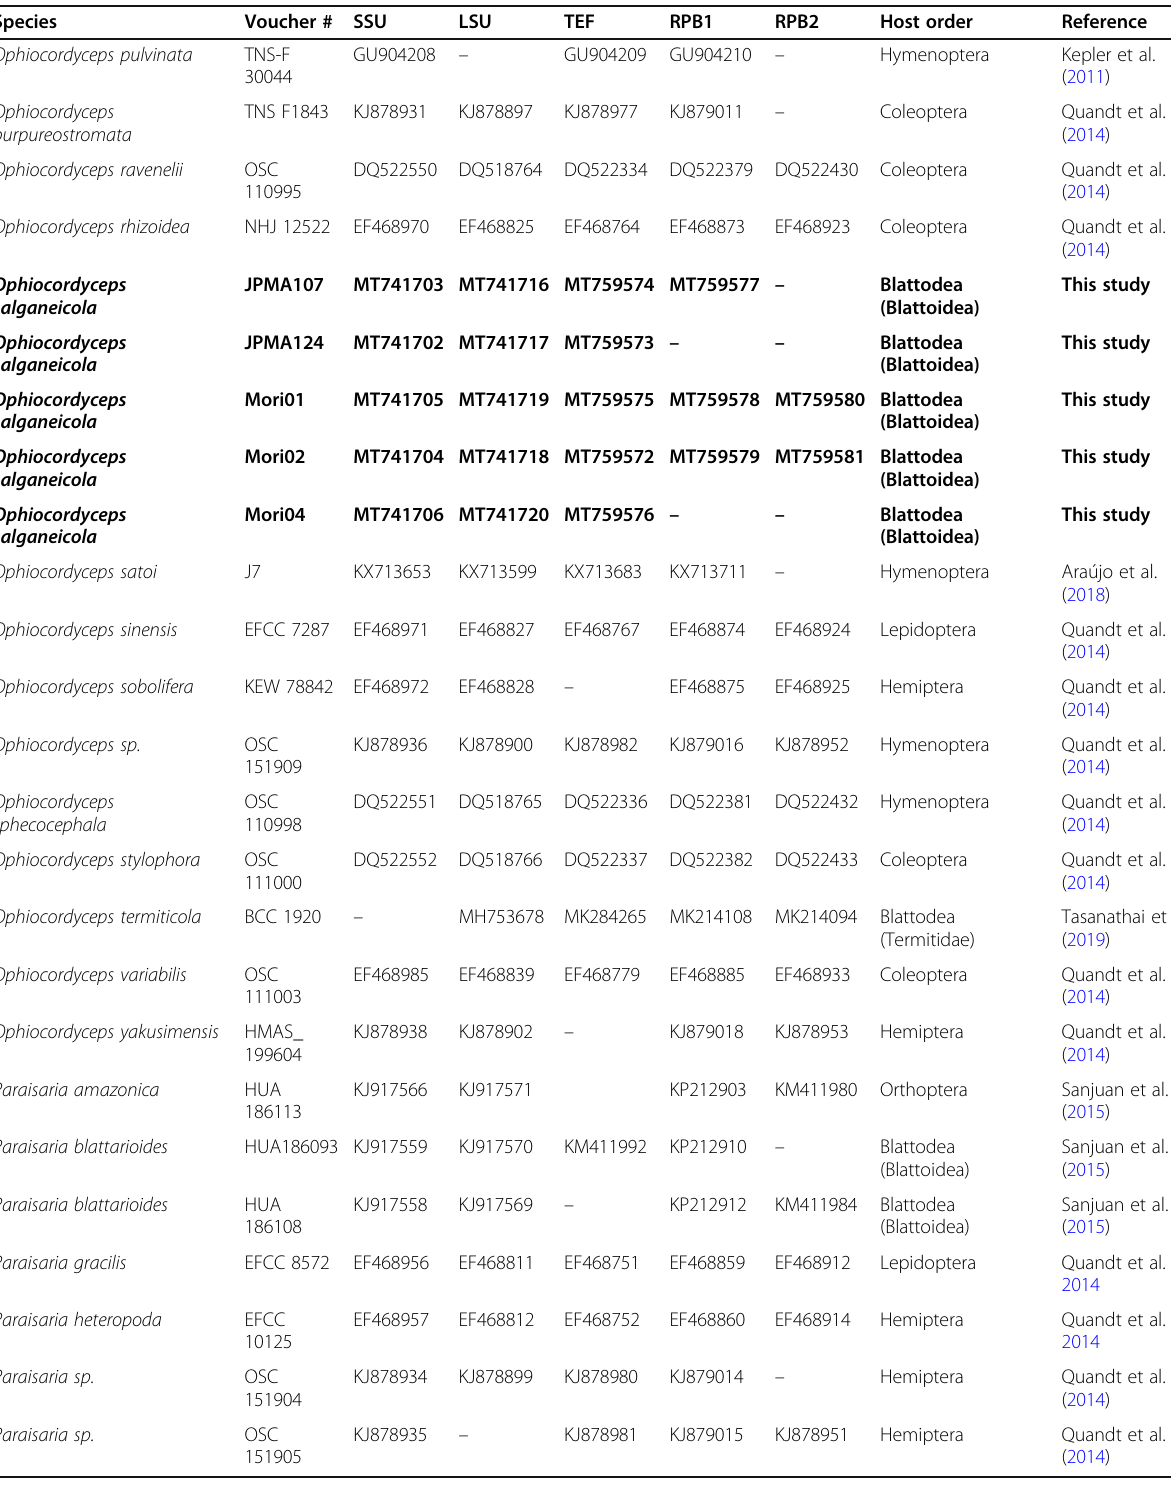
Table 3 Genbank accession number, host association and reference for all Ophiocordyceps species used in this study (Continued)